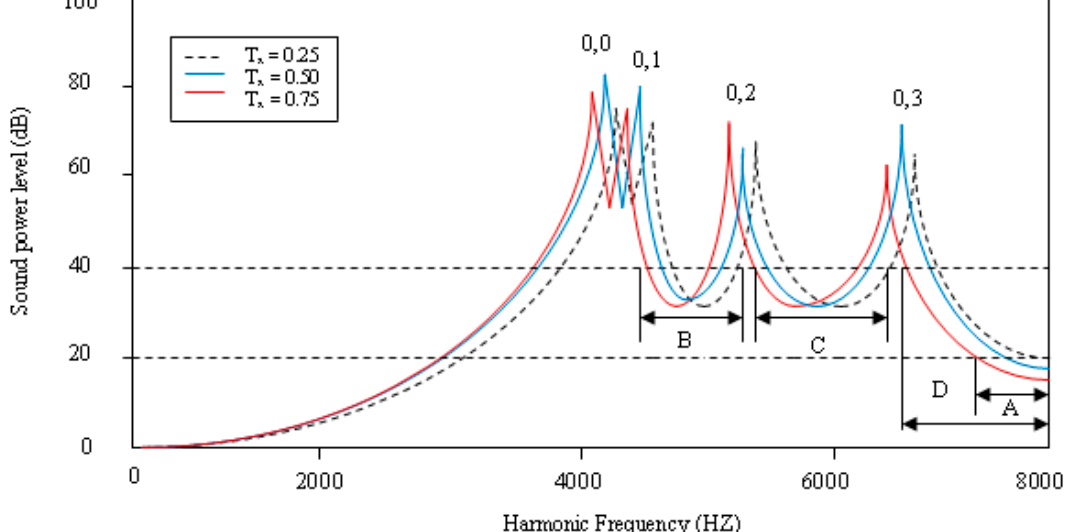
Figure 12. Numerical comparison of sound power level for annular plate attached with 4 rectangular stiffener patches and having parabolic decreasing thickness variations (Case I) for different taper ratios T x .